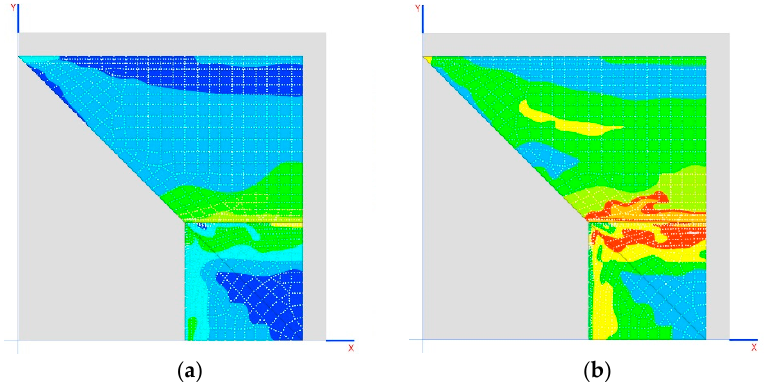
Figure 17. ( a ) The tension in the vaults are of the order of 2 MPa, considering the same conditions as for the dome; ( b ) the possibility of cracks in the direction of the gallery for tensioners greater than 0.3 MPa.